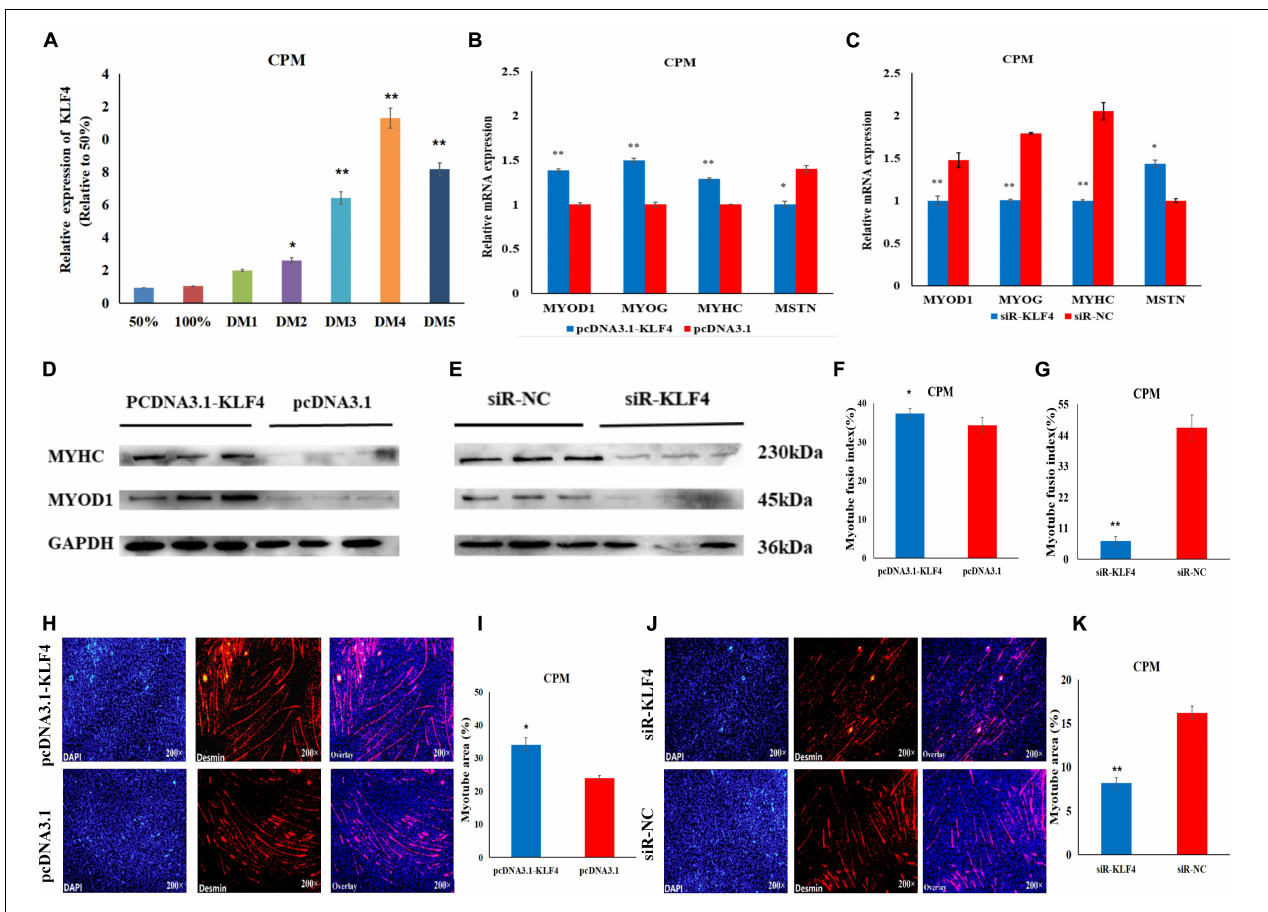
FIGURE 6 | KLF4 promotes the differentiation of CPMs. (A) The expression level of KLF4 during the proliferation (50 and 100% confluency) and differentiation of CPMs. DM1, DM2, DM3, DM4, and DM5 represent CPMs which were induced to differentiate for 24, 48, 72, 96, and 120 h, respectively. (B,C) The mRNA expression of MYOD1, MYOG, MYHC and MSTN 48 h after the overexpression and inhibition of the KLF4 gene in CPMs. (D,E) The protein expression of MYHC and MYOD1 72 h after the overexpression and inhibition of the KLF4 gene in CPMs using Western Blot. (F,G) The myotube fusion index (%) of the CPMs after KLF4 overexpression and inhibition. (H,J) Immunofluorescence analysis of Desmin-staining cells after KLF4 overexpression and inhibition. (I,K) The myotube area (%) of the CPMs after KLF4 overexpression and inhibition. Photomicrographs were taken using a 200 × magnification. The results are shown as the mean ± SEM of three independent experiments, * p < 0.05, ** p <